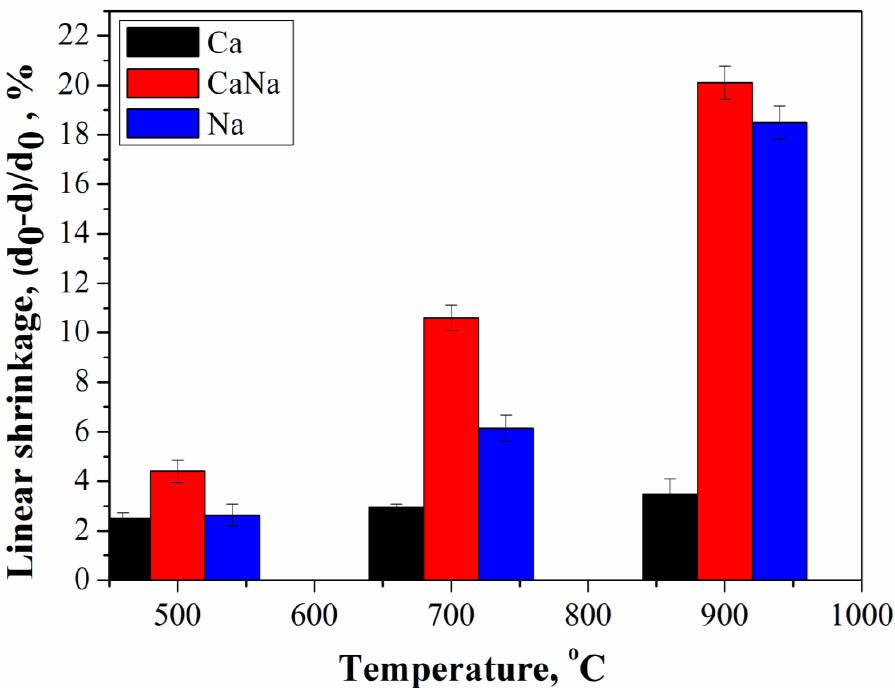
Figure 6. Linear shrinkage of ceramic samples obtained by annealing of cement-salt stone in the temperature range of 500 – 900 °C.